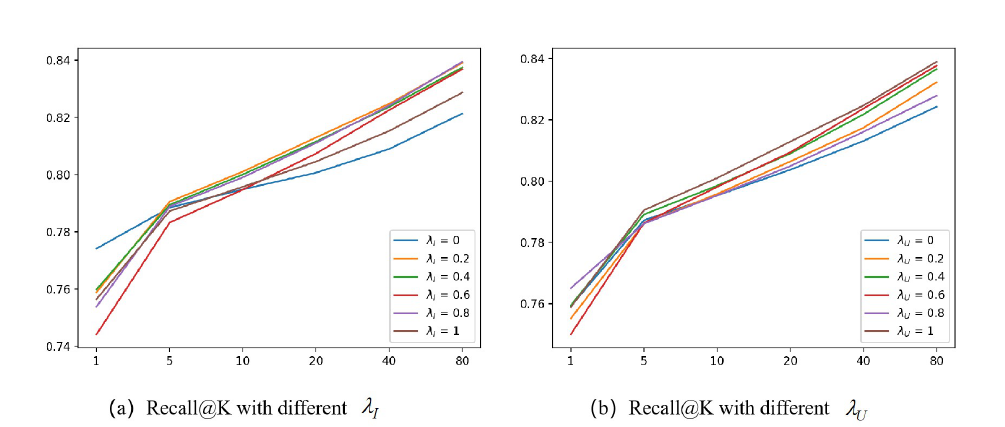
Figure 8. ( a ) Recall@K with different λ I when λ U = 1. ( b ) Recall@K with different λ U when λ I = 0.2.